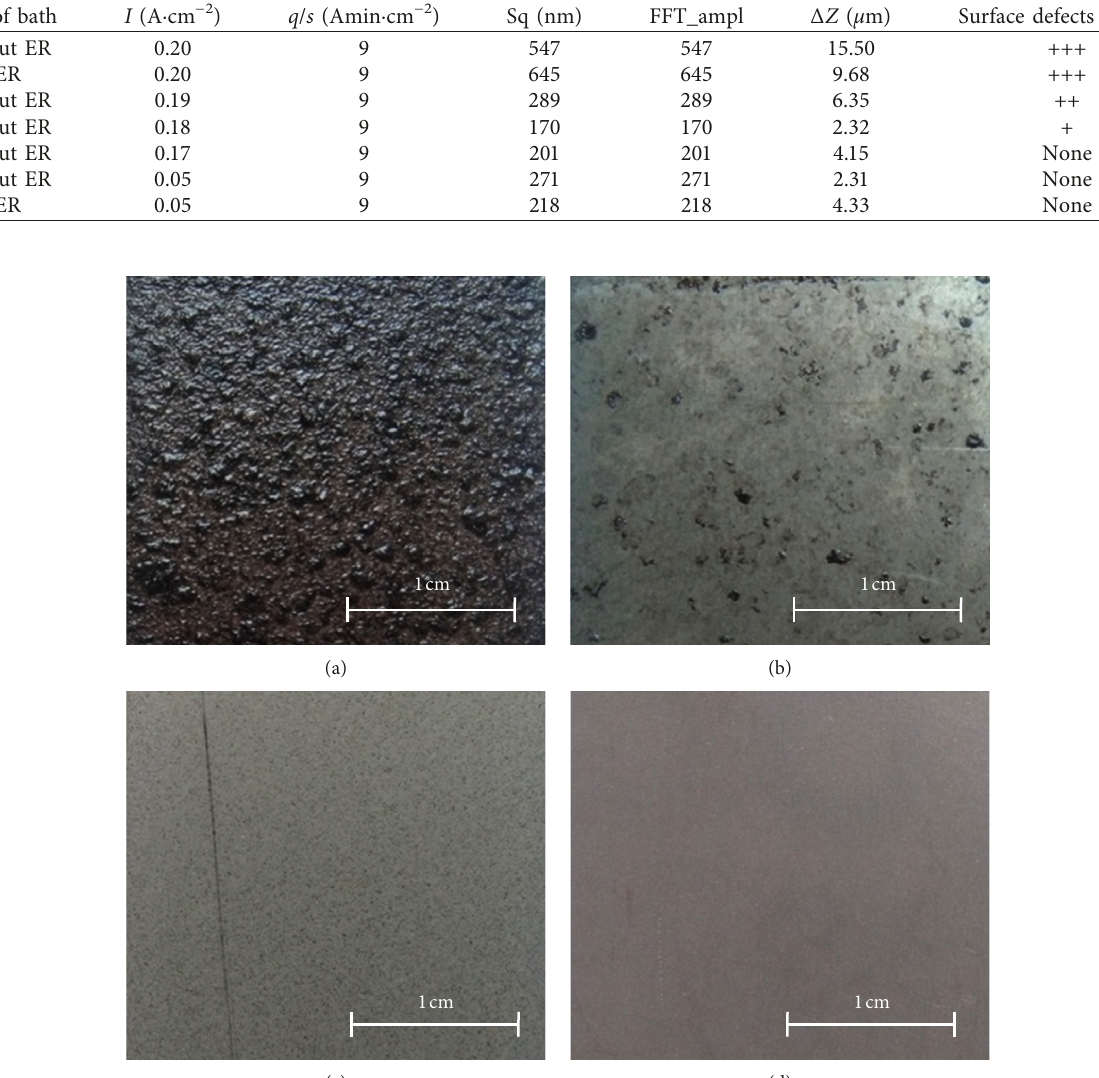
Table 2: Sample surface roughness in the area of noticed